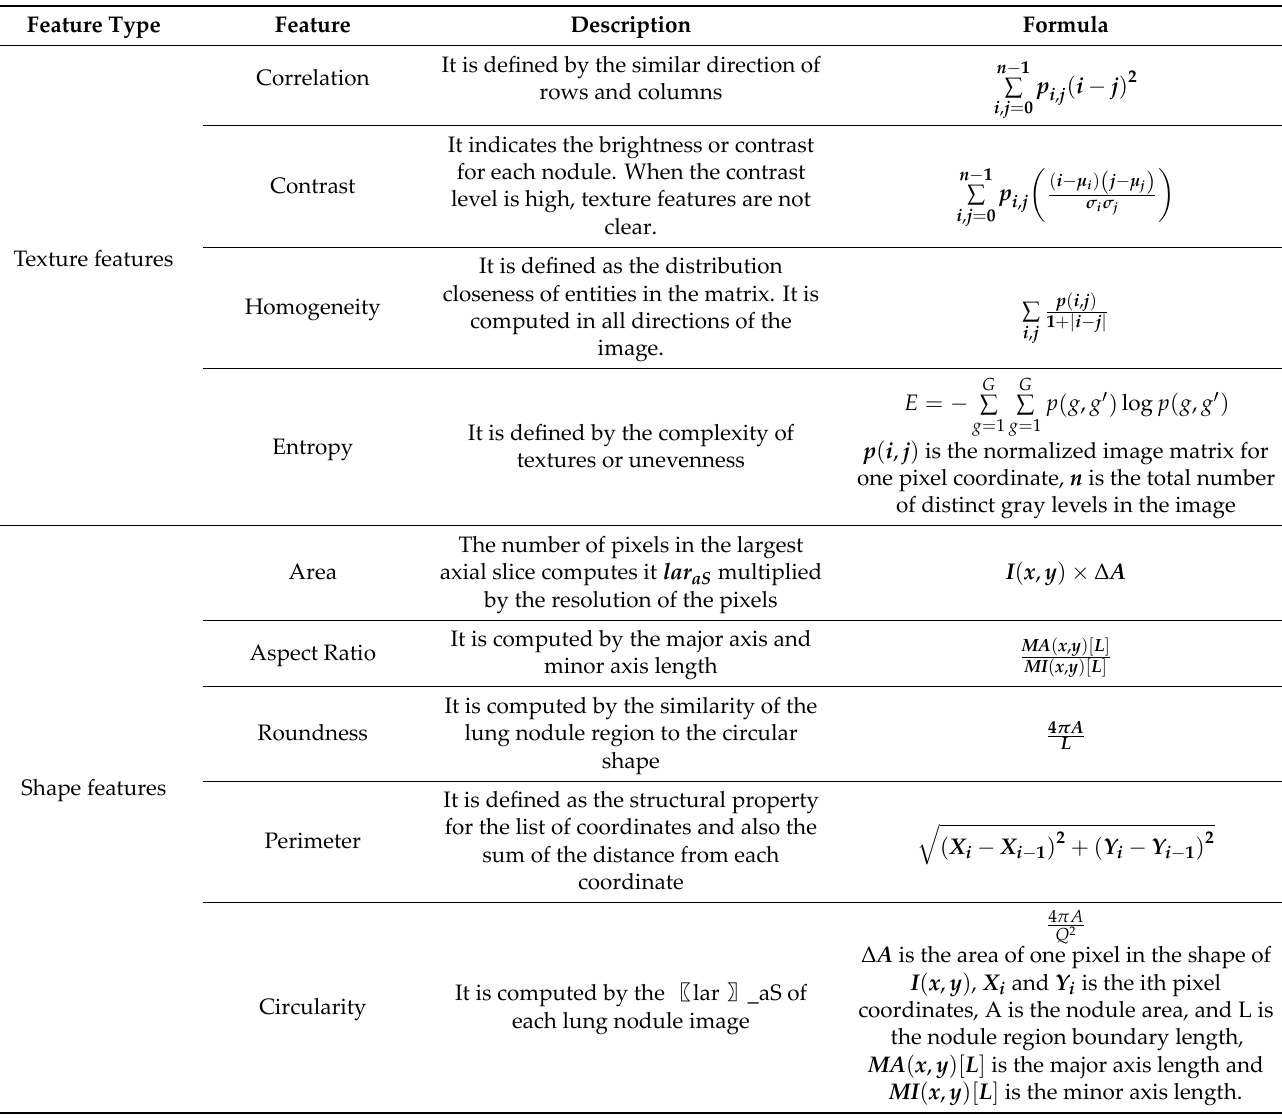
Table 1. List of extracted